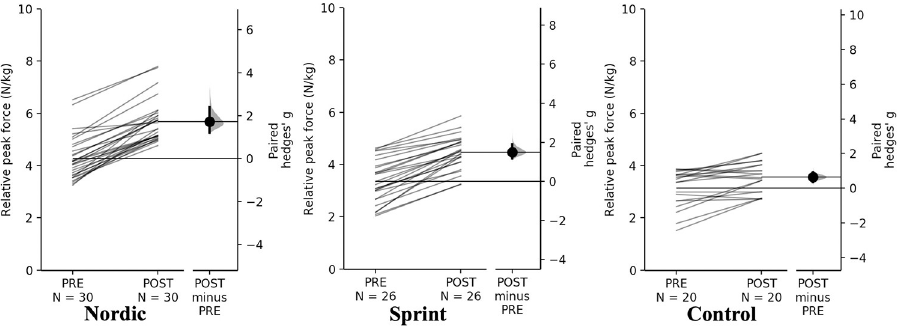
Fig 5. Gardner-Altman estimation plots identifying Pre- and Post-intervention individual changes for relative peak eccentric hamstring force and Hedge’s g effect size with the 95% CI indicated by the ends of the vertical error